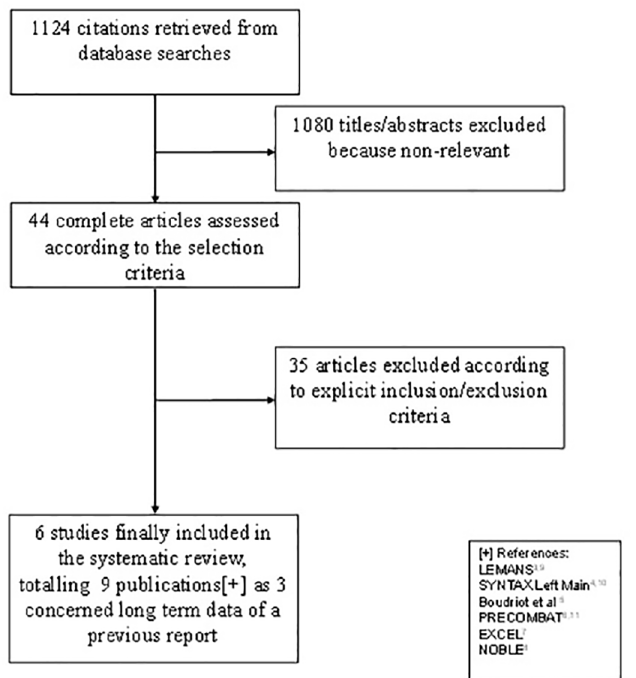
Fig 1. Flow diagram of study